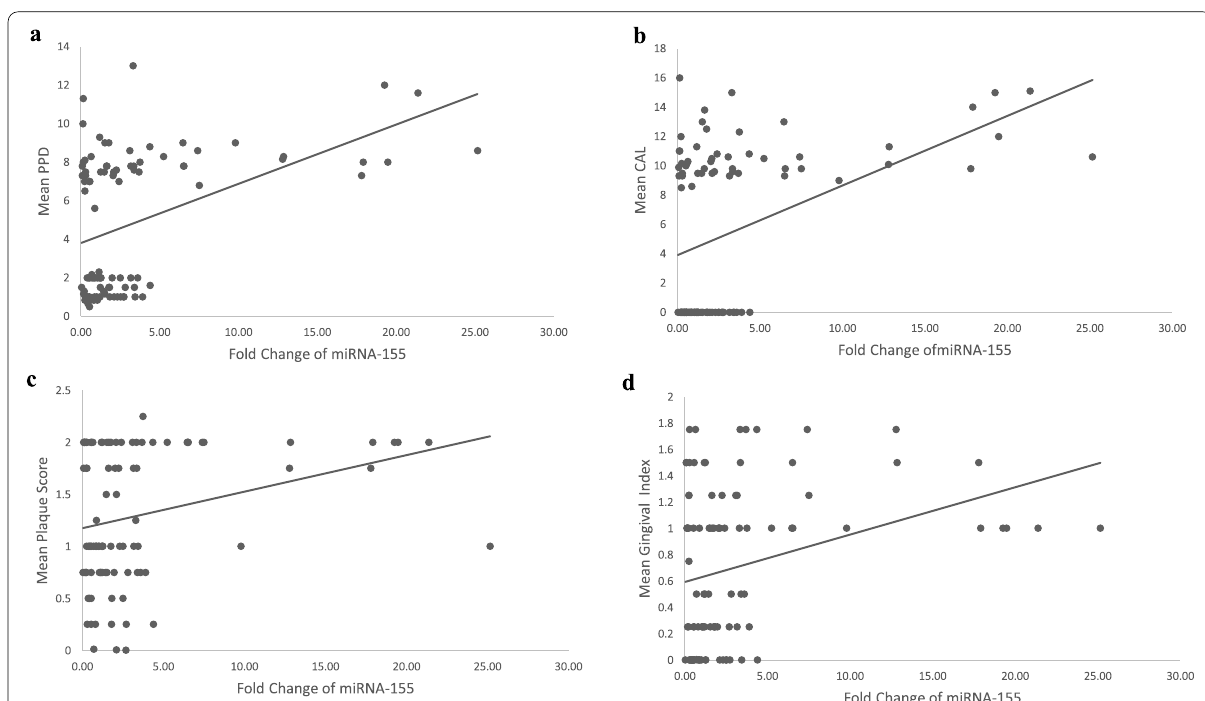
Fig. 2 a Scatter plot showing the correlation between fold change of miRNA-155 with site-specific mean PPD in 98 subjects. b Scatter plot showing the correlation between fold change of miRNA-155 with site-specific mean CAL in 98 subjects. c Scatter plot showing the correlation between fold change of miRNA-155 with site-specific mean Plaque score in 98 subjects. d Scatter plot showing the correlation between fold change of miRNA-155 with site-specific mean Gingival Index score in 98